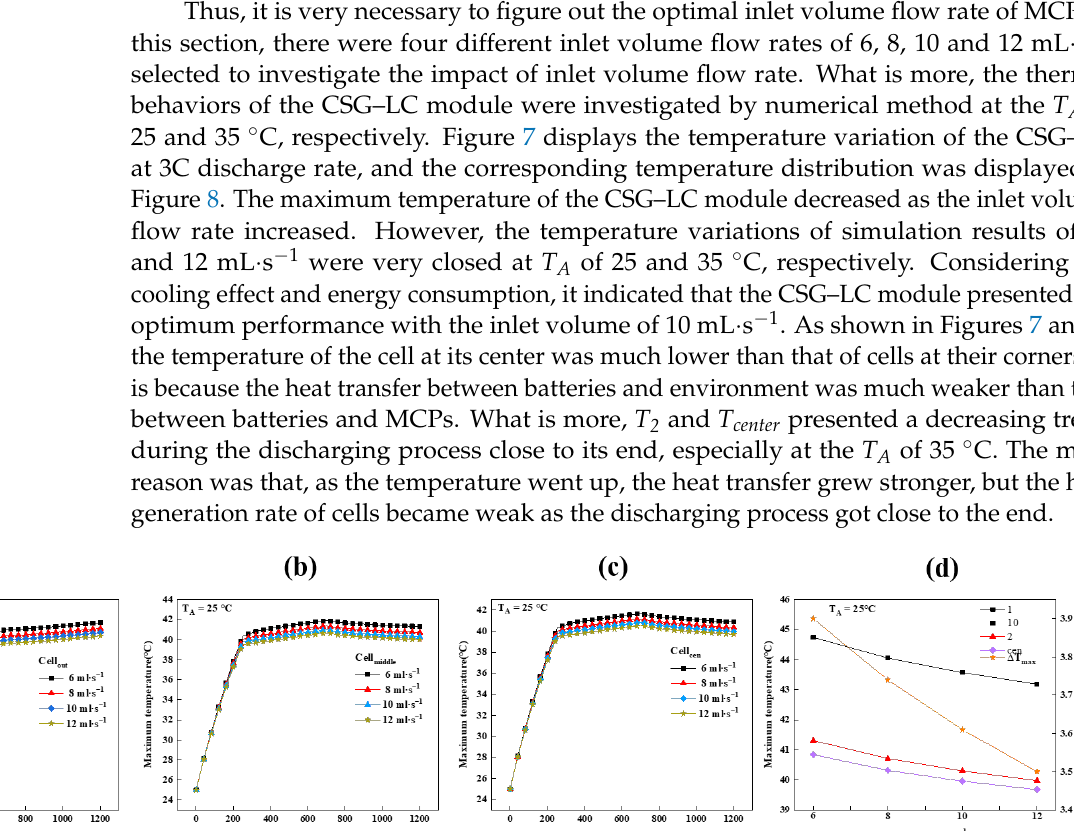
Figure 8. Temperature distribution of the CSG – LC module under different volume flow rate: ( a , e ) 6; ( b , f ) 8; ( c , g ) 10 and ( d , h ) 1 2 mL∙ s −1 at 25 and 35 °C. 4.2.2. The Effect of the Flow Channel The flow channel also has significant impact on the cooling performance of the CSG – LC module. On the basis of the temperature distribution of volume flow rate, the inlet volume flow rate of 1 0 mL∙ s −1 and the T A of 25 °C were selected to investigate the impact